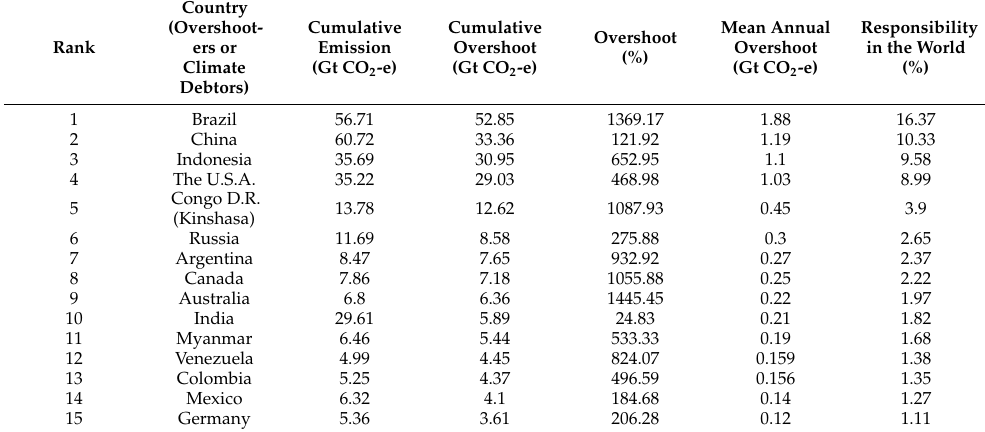
Table 1. List of top overshooting countries ( n = 15) for climate change fair shares of the food system. Country (Overshoot- Cumulative Rank ers or Emission Climate (Gt CO 2 Debtors)